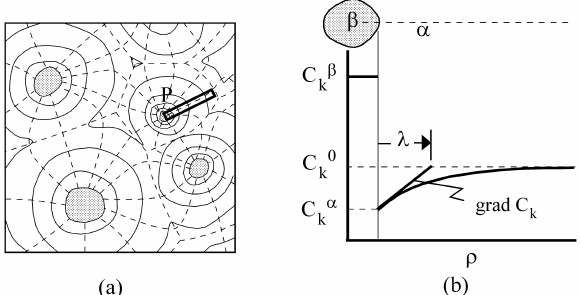
Figure 12. (a) Two dimensional sketch of a diffusion generated concen- tration field for β precipitating in α , showing the isoconcentration con- tours and flux lines. (b) For any point P on the αβ interface the concentration gradient in the α along the flux line can be described by a α ) and a diffusion lenght scale, λ . composition difference (C k0 - C k